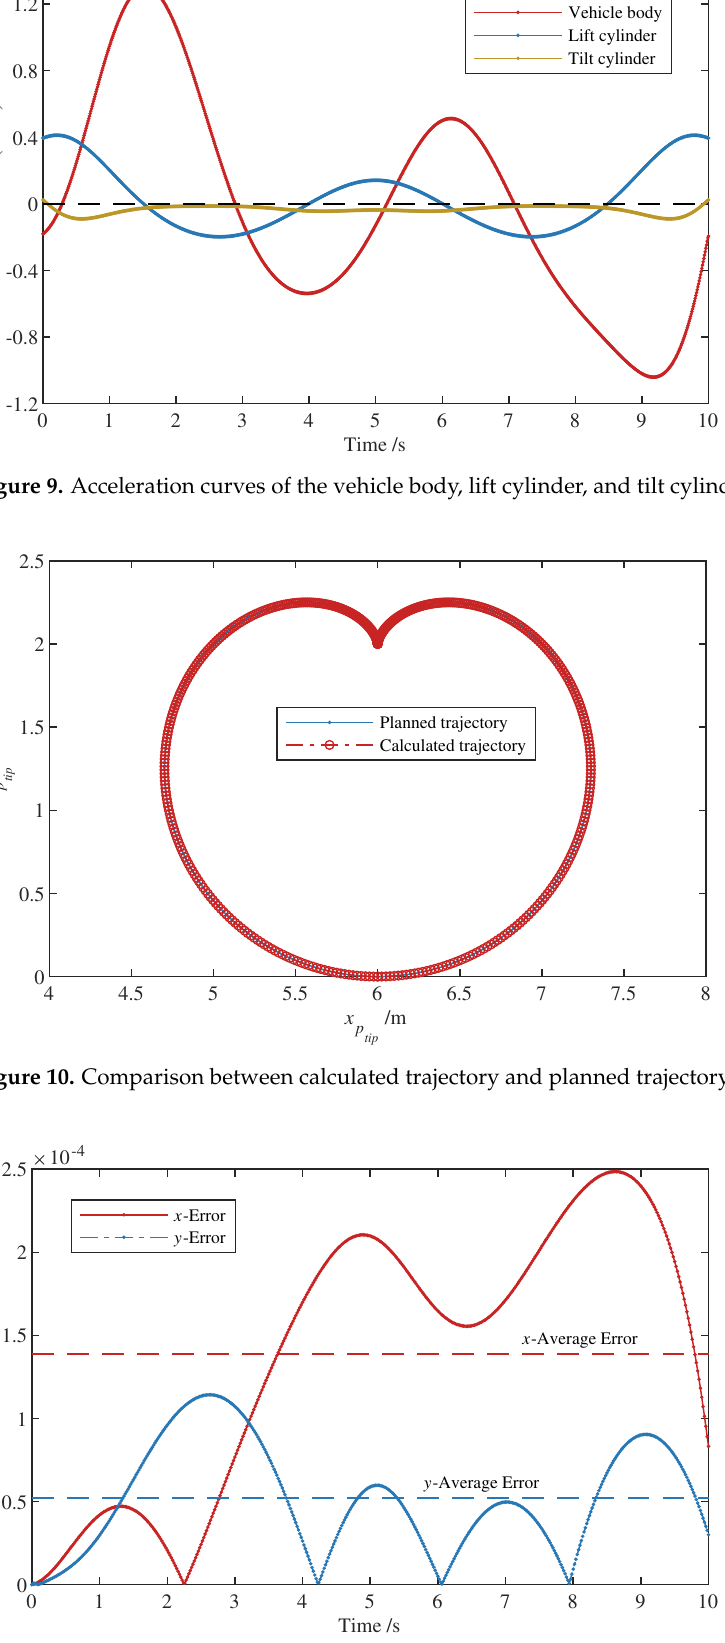
Figure 11. Error analysis of calculated trajectory of bucket tip P tip